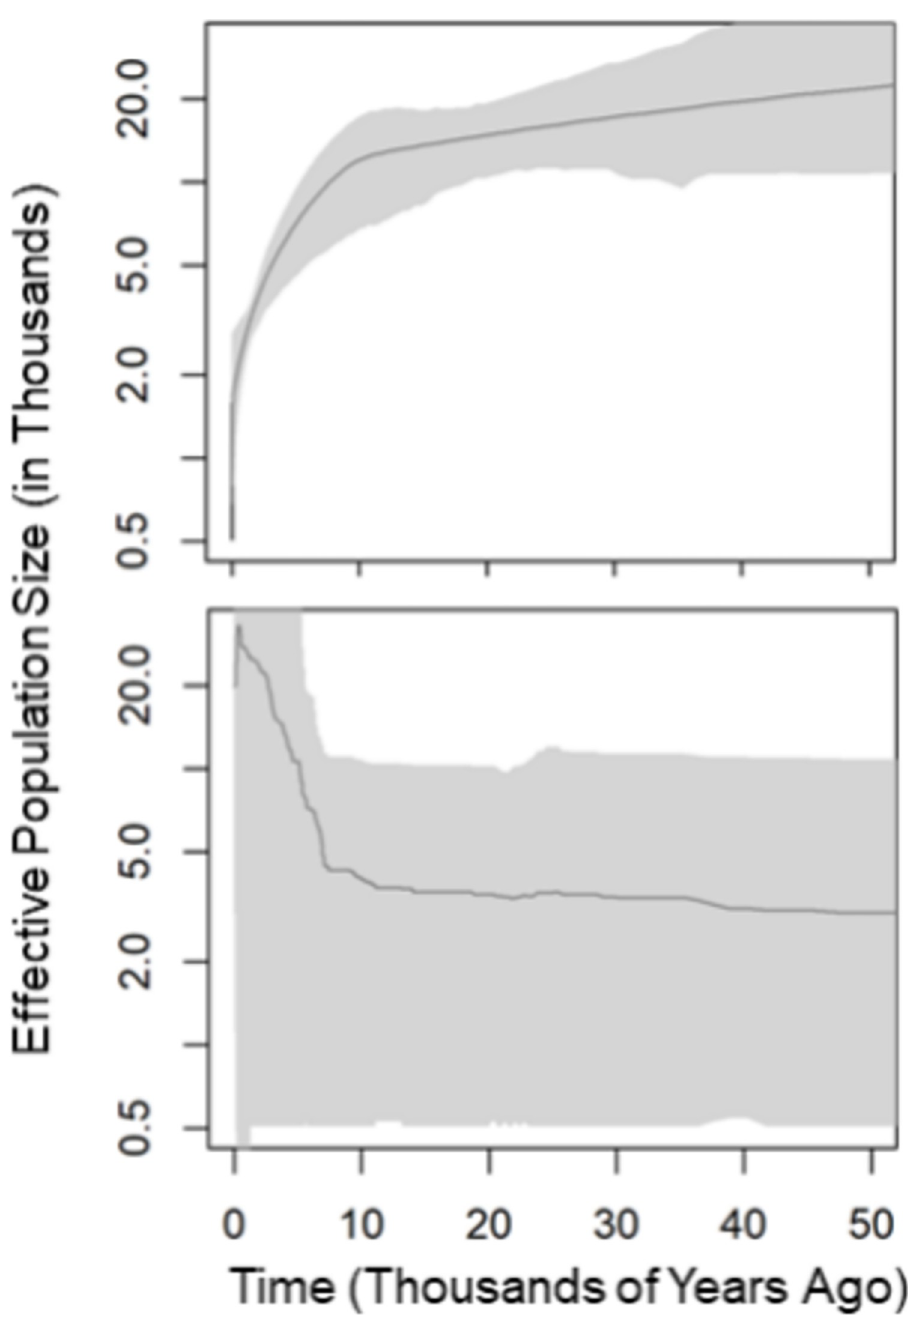
Fig 2. Extended Bayesian Skyline Plot for Dipodomys elator (top) from 34 individuals and 47 loci and for D . ordii (bottom) from 15 individuals and 49 loci. X-axis is thousands of years ago. Y-axis is effective population size (N e ) in thousands. The y-axis is on a log scale. The dark line on each plot is the mean effective population size, while the shaded gray portions represent the upper highest posterior density (HPD) estimate and the lower highest posterior density